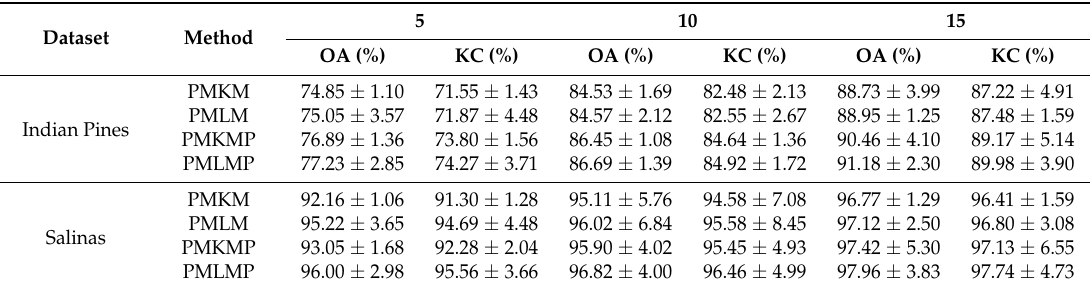
Table 1. Classification results of the Indian Pines and Salinas datasets by different methods with different label